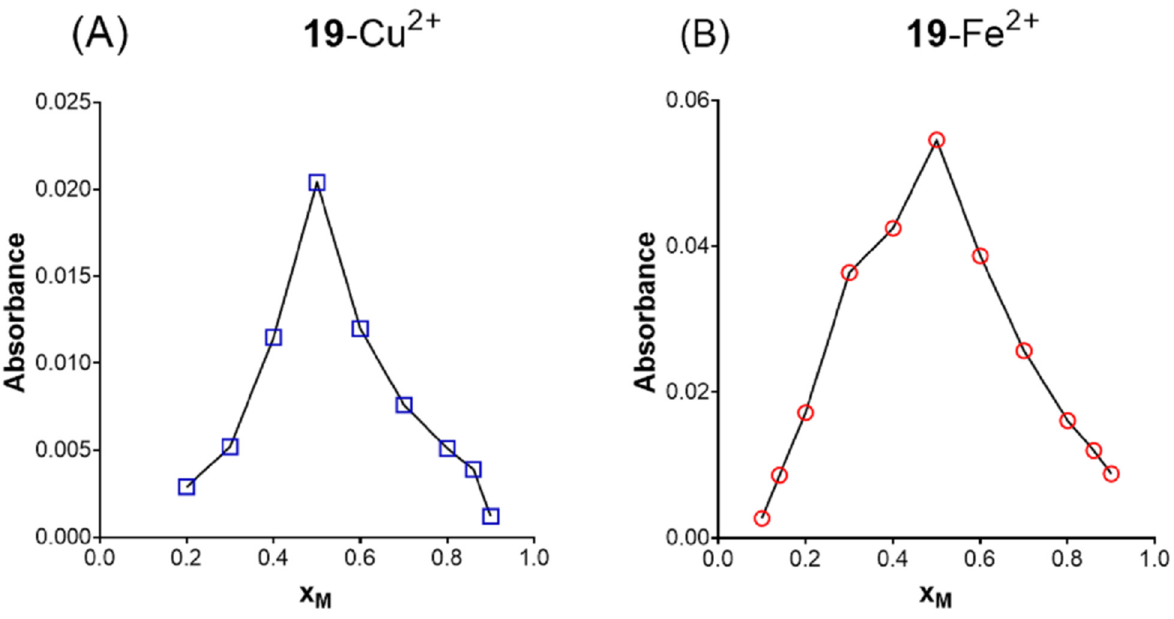
Figure 6. Determination of the stoichiometry of ( A ) 13 –Cu 2+ complex and ( B ) 13 –Fe 2+ complex with a breakpoint observed at biscarbamate:metal ratio = 1:1.